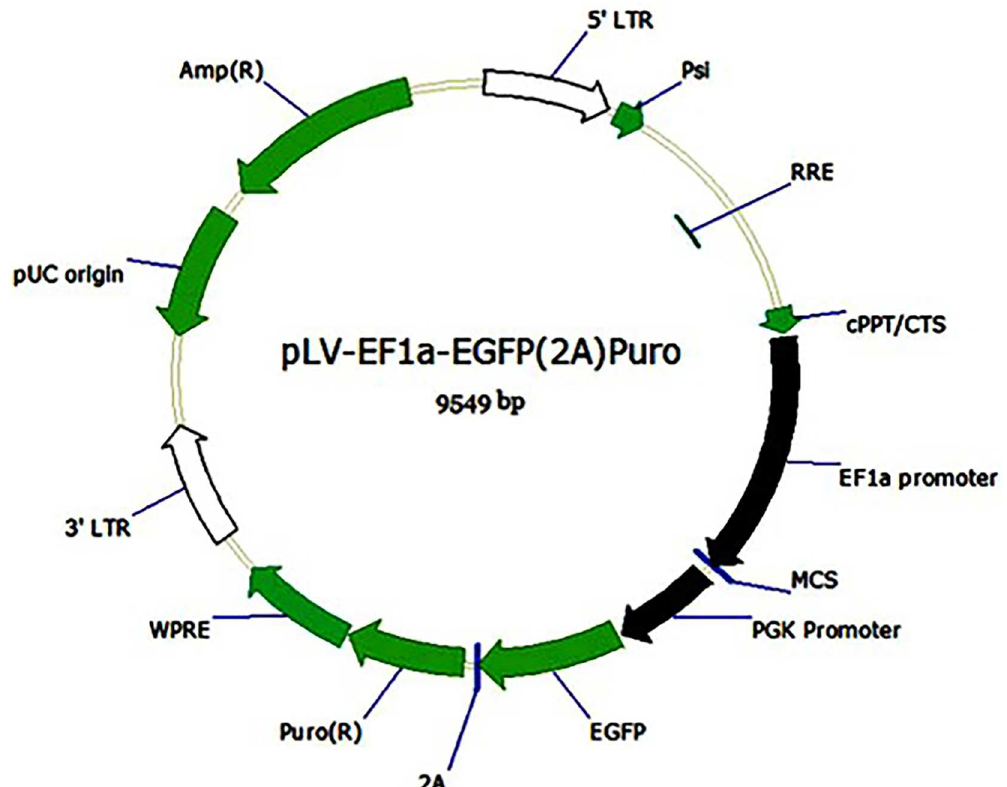
Fig 1. Map of the pLVEF1a-EGFP(2A)-Puro vector for lentivirus delivery.